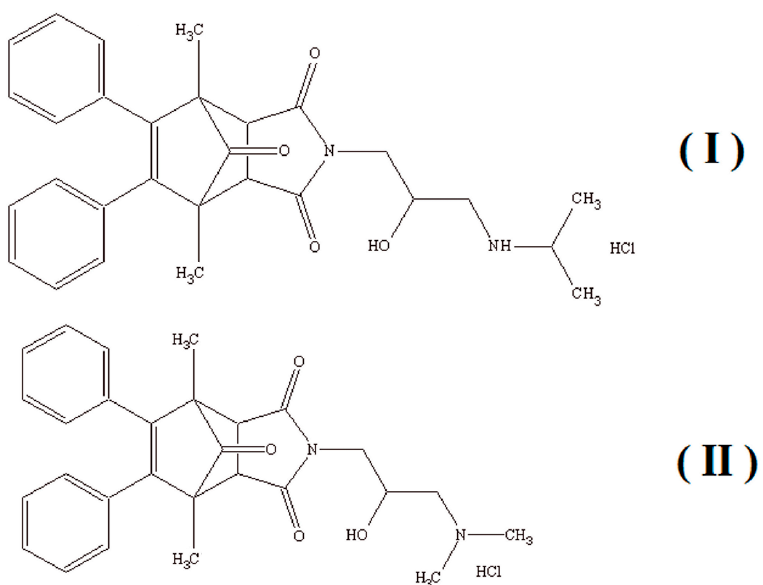
Figure 1. Structures of compounds (I) (4-[2-hydroxy-3-(propan-2-ylamino)propyl]-1,7-dimethyl-8,9-diphenyl-4-azatricyclo [5.2.1.0 2,6 ] dec-8-ene-3,5,10-trione hydrochloride) and (II) (4-[3-(dimethylamino)-2-hydroxypropyl]-1,7-dimethyl-8,9-diphenyl-4-azatricyclo[5.2.1.0 2,6 ]dec-8-ene-3,5,10-trione hydrochloride).